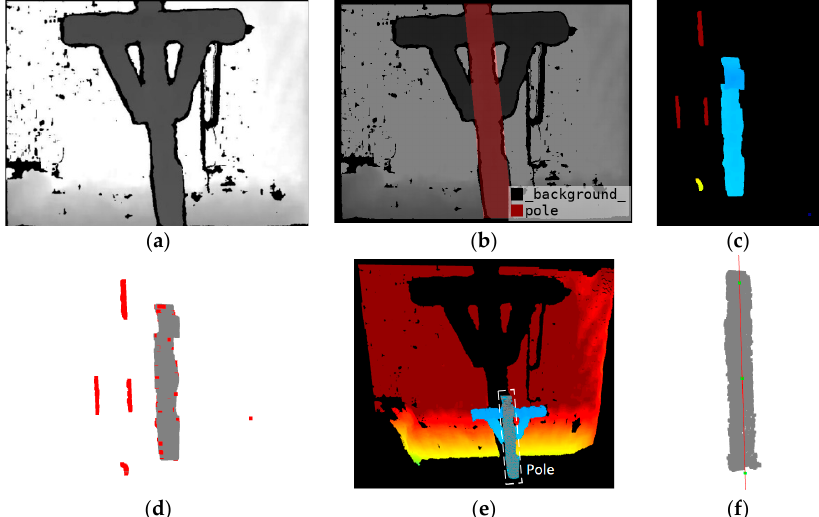
Figure 19. Intermediate process of the pole inclination angle. ( a ) Pole depth map; ( b ) Image segmen- tation; ( c ) Frustum point cloud; ( d ) Preprocessing and segmentation; ( e ) Pole segmentation results, where the pole points are in the white dot line box; ( f ) Central axis fitting.